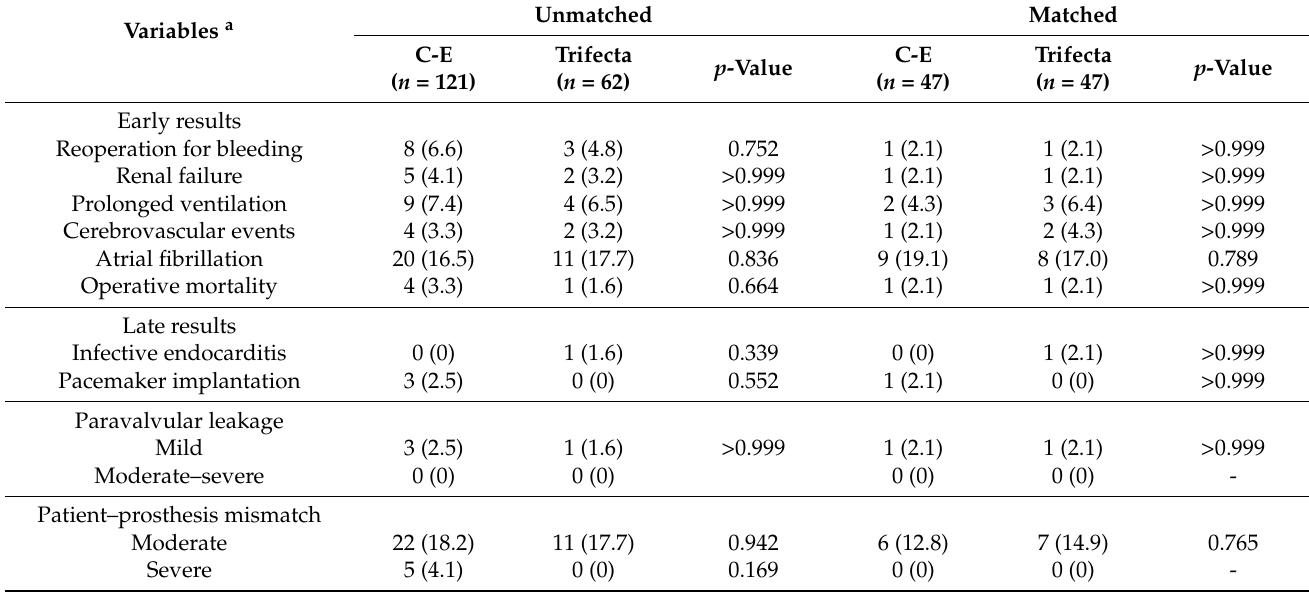
Table 2. Early and late clinical outcomes of the unmatched and matched